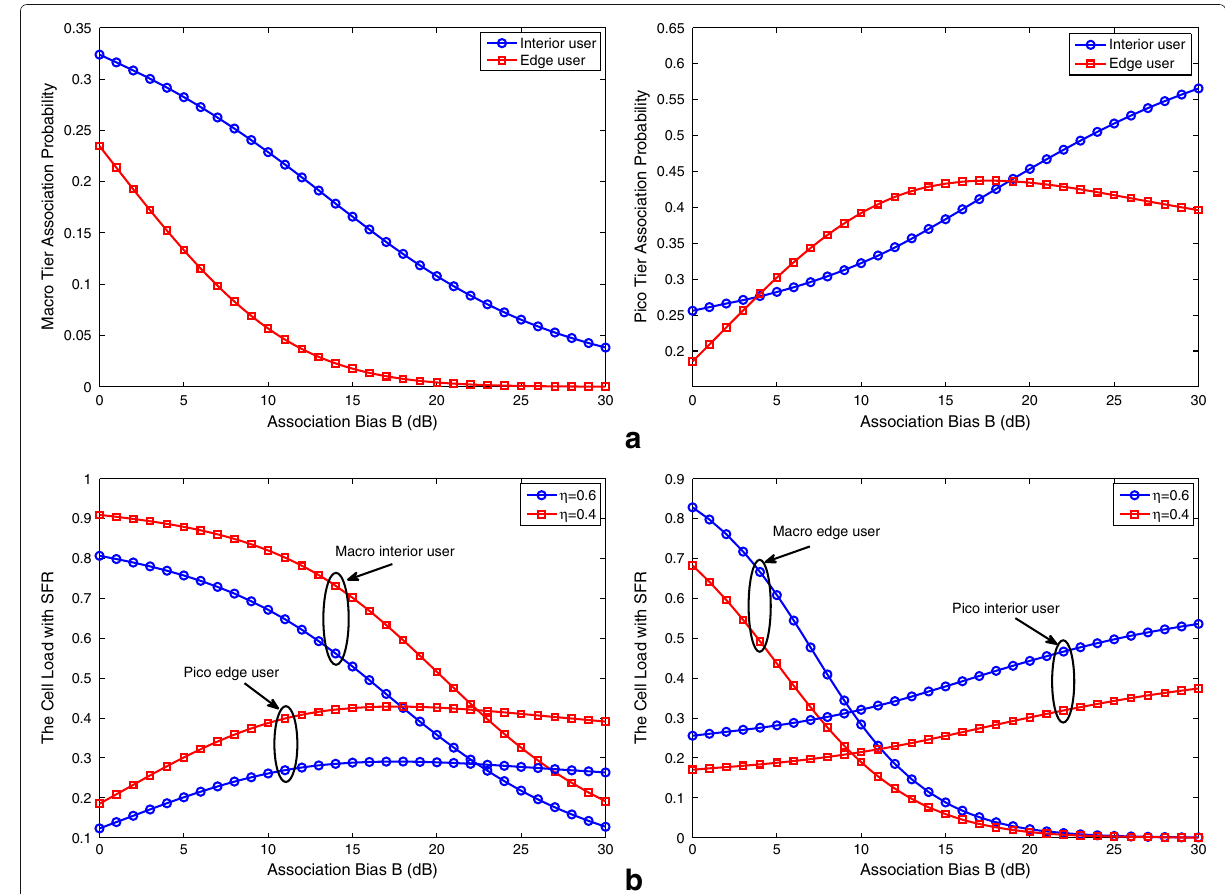
(cid:18) (cid:19) (cid:18) (cid:18) (cid:19)(cid:19) T FR, k and A k 1 − p c , k T FR, k that a user in the k th tier is an interior user and edge user, respectively.